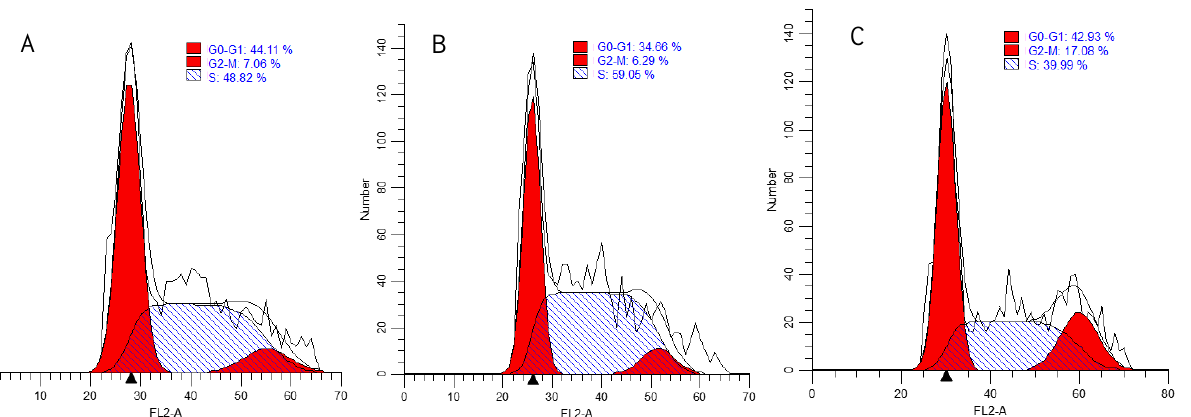
Figure 4. In-Cell Western analysis of predicted protein targets of NO- ∆ -16-CIEA 14a : ( A ) Analysis of EGFR phosphorylation in HepG2 cells; ICW plate image and p-EGFR intensity in 800 channel was normalized to total EGFR intensity in 700 channel. ( B ) Analysis of ERK1/2 phosphorylation in HepG2 cells; ICW plate image and p-ERK1/2 intensity in 800 channel was normalized to total ERK1/2 intensity in 700 channel. ( C ) Analysis of MEK1/2 phosphorylation in HepG2 cells; ICW plate image and p-MEK1/2 intensity in 700 channel was normalized to β -actin intensity in 800 channel. ( D ) Analysis of MRP2 inhibition in HepG2-R cells; ICW plate image and MRP2 intensity in 800 channel was normalized to GAPDH intensity in 700 channel. Values reported are averages ± SD of at least two measurements.